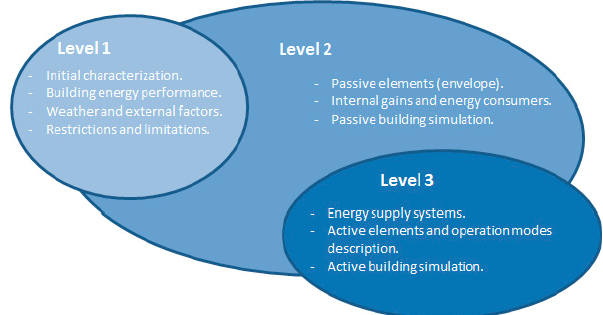
Figure 3. Three-level simulation approach.